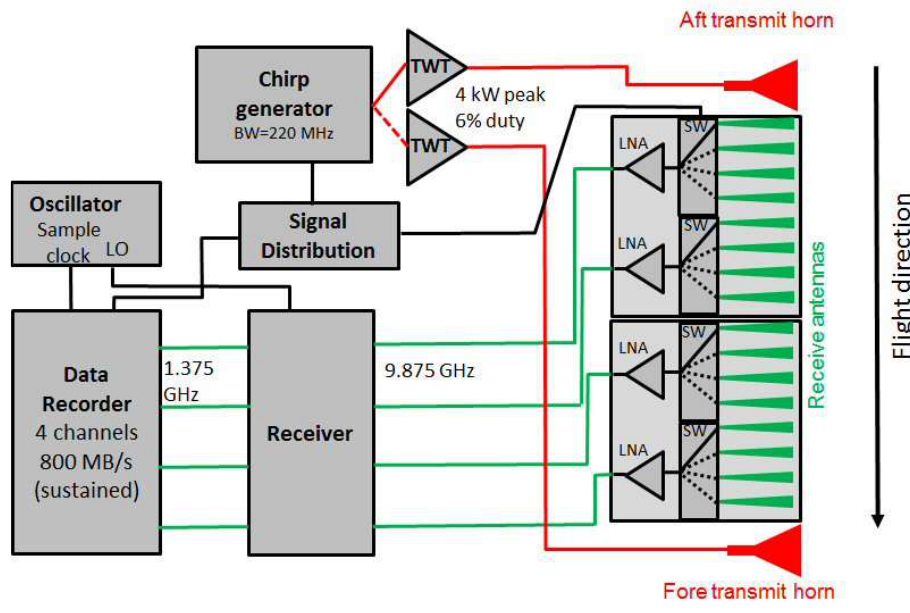
Figure 8. MSAR block diagram.